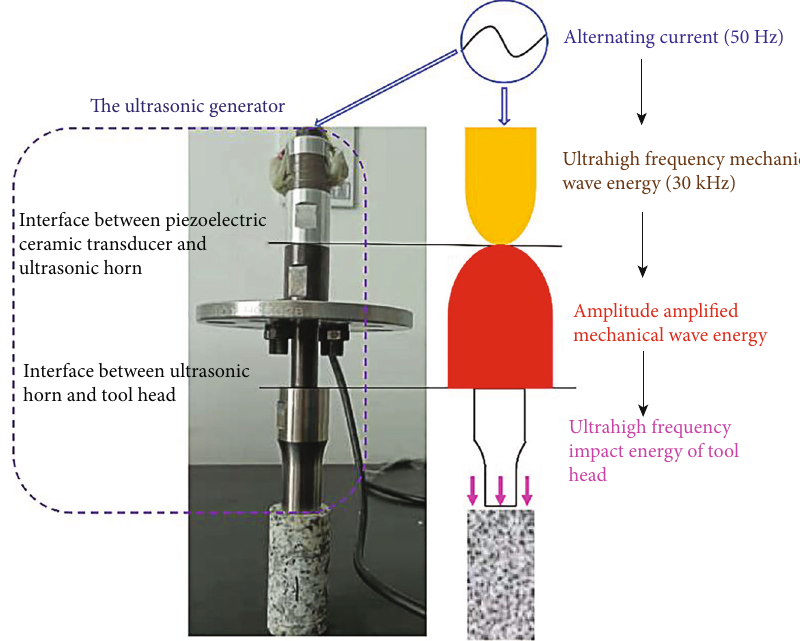
Figure 2: Generation mechanism of ultrahigh frequency